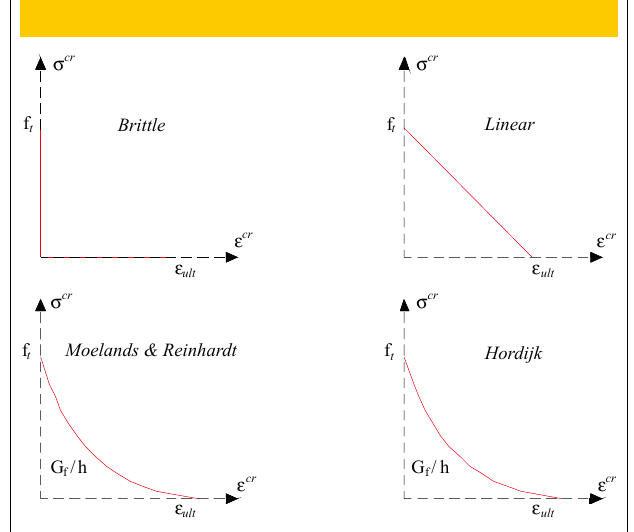
Figure 1 – Material softening models –